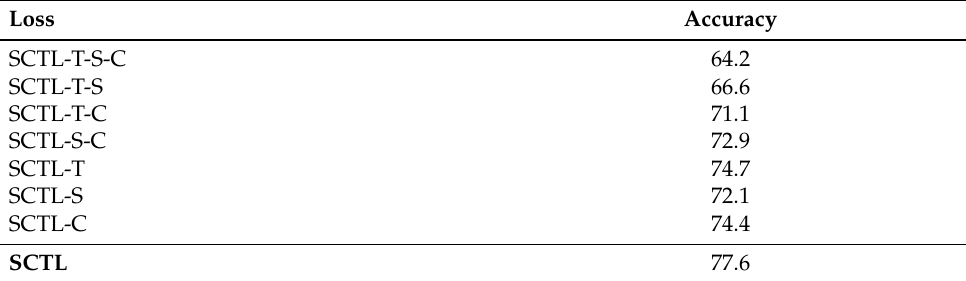
Table 5. Ablation study of different loss functions on test